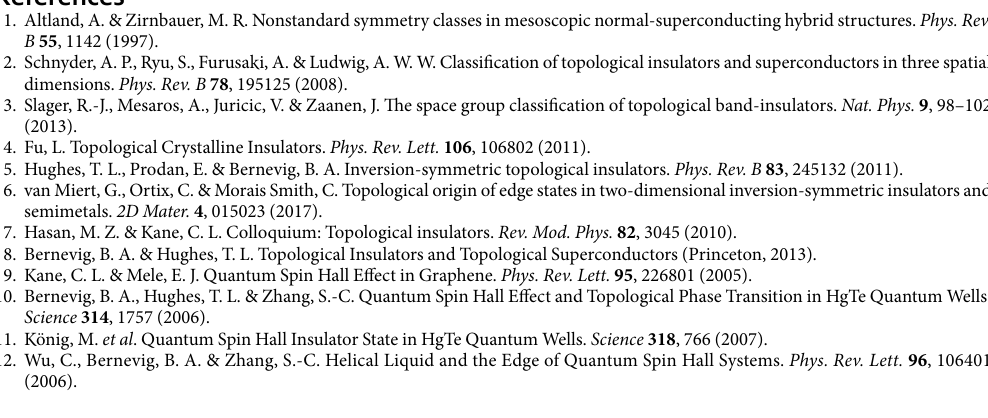
Fig. 2b. The dielectric constant of the medium here plays the same role of Feshbach resonances in ultracold atoms, which allow to tune the interaction parameter from the repulsive to the attractive regime 40 .